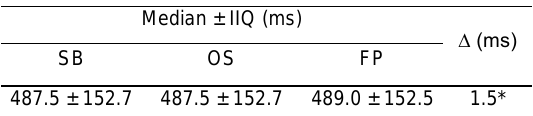
Table 1. Comparison of flight time measurement by the SaltoBras and Force Plate (n=90).